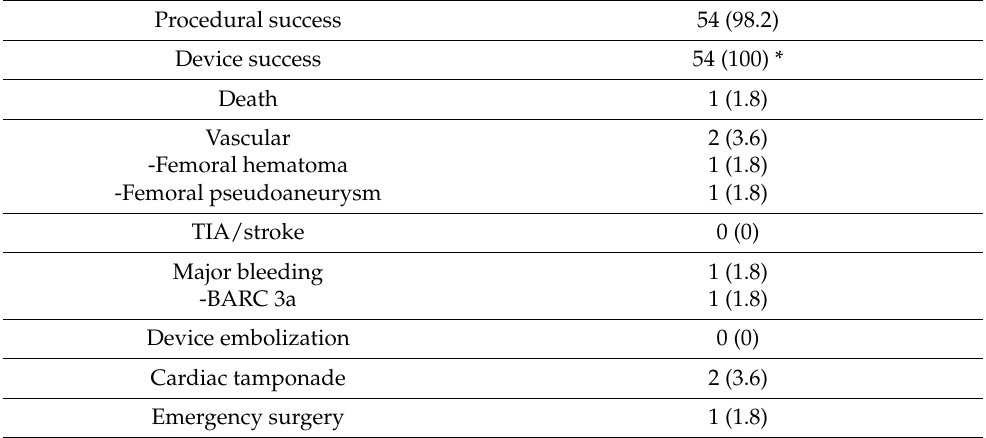
Table 3. Periprocedural complications ( n = 55).